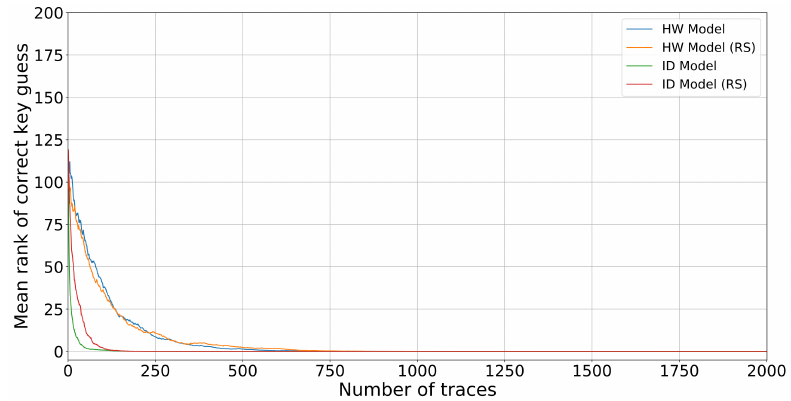
Figure 5: Guessing entropy for the ASCAD with the fixed key